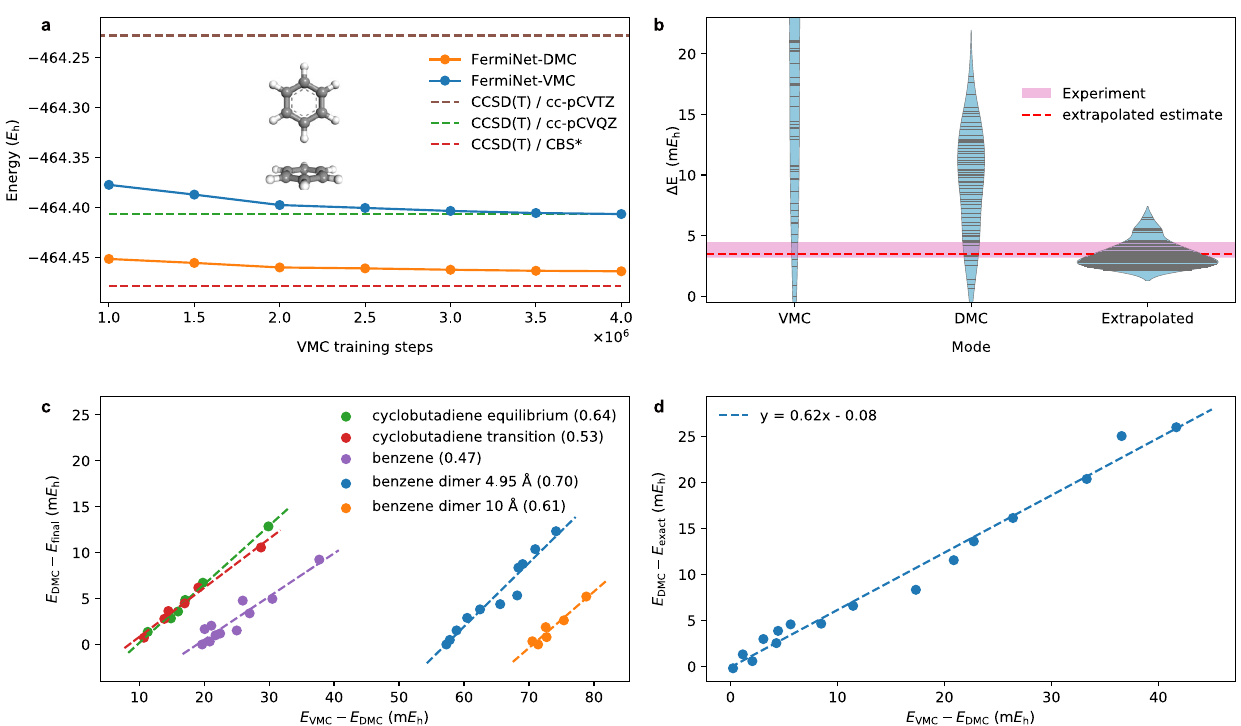
Fig. 5 | Benzene dimercalculated energy and the extrapolation basedonVMC- DMClinearrelation.a TheenergyoftheT-shapedbenzenedimerwithacenter-to- center distance of 4.95 Å as well as the CCSD(T) results asbaselines. The CCSD(T)/ CBS* result is calculated using binding energy and monomer energy. See Supple- mentary Note 14 for details. b The fi tted distribution of binding energy from VMC, DMC, and extrapolation results, where the solid lines inside each violin represent the actual data points. The energy for two separated benzene molecules is calcu- latedusingabenzenedimerseparatedby10 Å 43 .Theequilibriumcon fi gurationisa T-shaped structure with center-to-center distance of 4.95 Å 40 . The experimental range is from Grover et al. 46 . The extrapolation scheme is based on the empirical